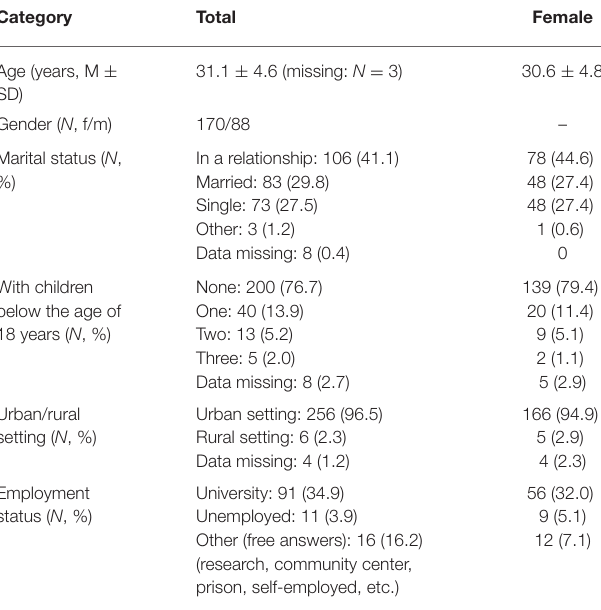
TABLE 2 | Factors relating to choice of